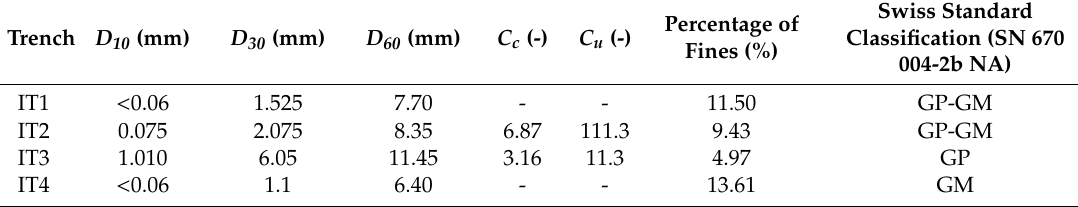
Table 5. Soil classification of scree soil from the instrumented trenches IT1-IT4.